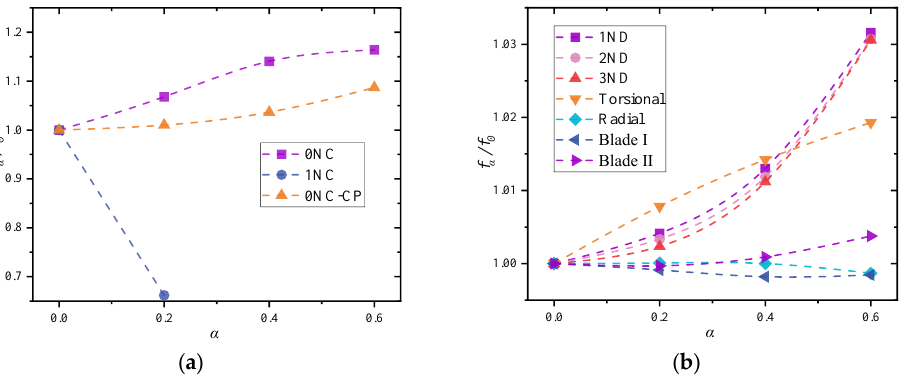
Figure 8. Variation of the natural frequencies with absorption boundary: ( a ) NC modes; ( b ) other